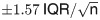
Analysis of relationship structures between features and Corrected Membrane Dynamics.(A) A Venn diagram summarizes the frequencies of particular relationship structures between features and changing values of Corrected Membrane Dynamics (CMD). Each circle of the Venn diagram contains two colors, indicating the CMD quintiles (blue, low; grey, intermediate; pink, high) from which feature values were compared via pairwise testing (low versus intermediate; intermediate versus high; low versus high). Segments of the Venn diagram indicate which combinations of pairwise tests (Wilcoxon rank sum test with Bonferroni correction) resulted in statistically discernable differences. The number of features is indicated for which a given combination of tests showed significance. To aid interpretation, schematic archetypes are included to indicate the type of correspondence that is observed between each feature and CMD. Where boxes do not overlap in the Y-axis, statistically significant differences were detected between feature values in the corresponding CMD groups. Note that the actual sign of feature responses may be inverted compared to these generalized archetypes. (B-K) The observed archetypes from (A) are illustrated to the left and examples of features corresponding to each archetype are shown in boxes to the right. Comparison brackets in each panel indicate significant differences (P<0.001 after Bonferroni correction, see Materials and Methods). Box plots show quartiles. Outliers are not shown. Notches are placed at the median value ±1.57 IQR/n, where n is the number of observations in each quintile (approximation of the 95% confidence interval of the median). (B) Mean CMAC lifetime and (C) median of Cell-Matrix Adhesion Complex (CMAC) mean LifeAct intensity per cell both show stably monotonic decreases across all CMD groups. (D) Coefficient of variation (CoV) of CMAC Speed is significantly different only between cell observations with low and high CMD, but not other pairs of groups. (E) Quartile dispersion (QD) of CMAC angle indicates the CMAC angle variability within a cell is significantly different between low and intermediate cell observations only. (F) The number of CMACs and the (G) median CMAC to center distance at each point in time both show a significant increase between the low and moderate CMD groups. The sum of paxillin (H) or LifeAct (I) content in the Cell-Matrix Adhesion Complexes (CMACs) both show a significant decrease between the intermediate and high CMD groups. They both indicate a possible maximum value at intermediate level. (J) Median of the CMAC paxillin intensity and (K) median CMAC Area both decrease significantly between intermediate and high CMD groups.